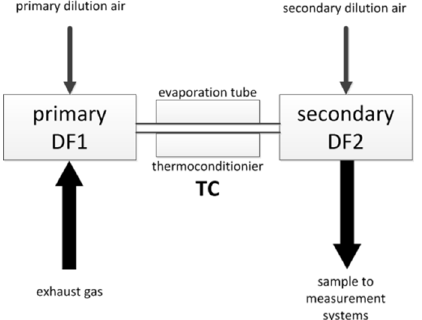
Fig. 2. Set-up of dilution stages and sample preparation for nanoparticle measurements